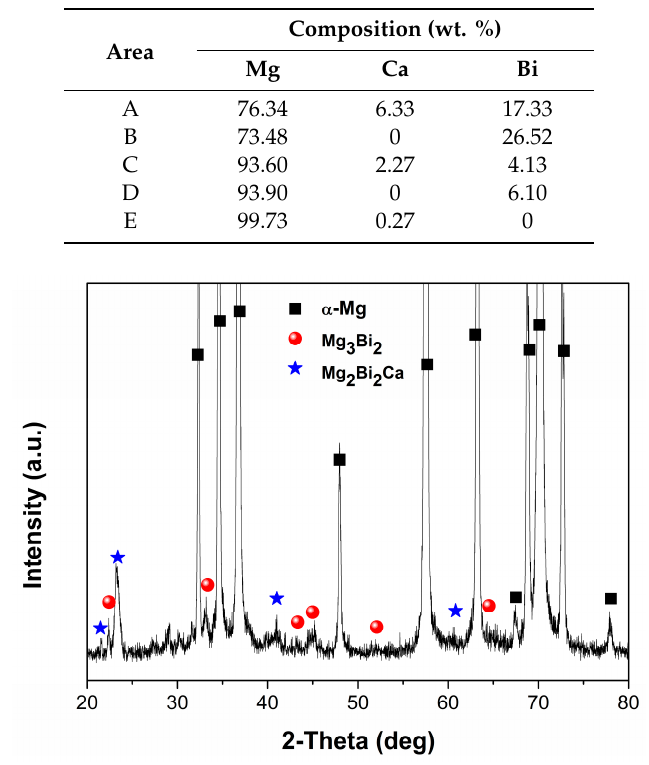
Figure 3. ( a,b ) Light microscope (LM) micrographs and ( c ) SEM images of as-extruded BX11 alloy. Table 2. Energy dispersive spectrometer (EDS) results of the particles in the matrix of as-extruded BX11 alloy.